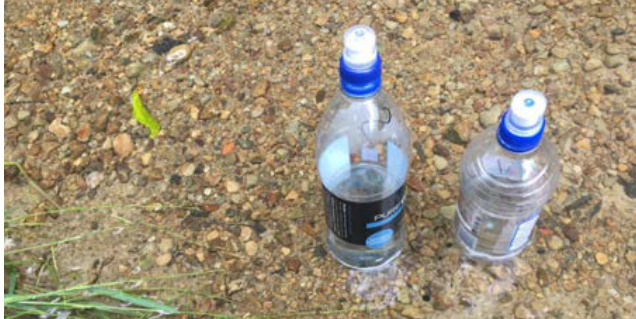
Figure 3: Plastic bottles used to collect stream water samples for testing sensors in the electronics